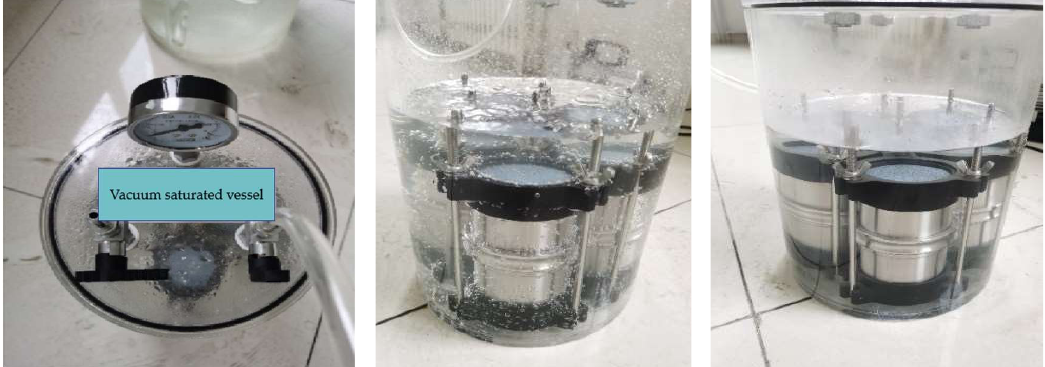
Figure 4. Vacuum saturation.